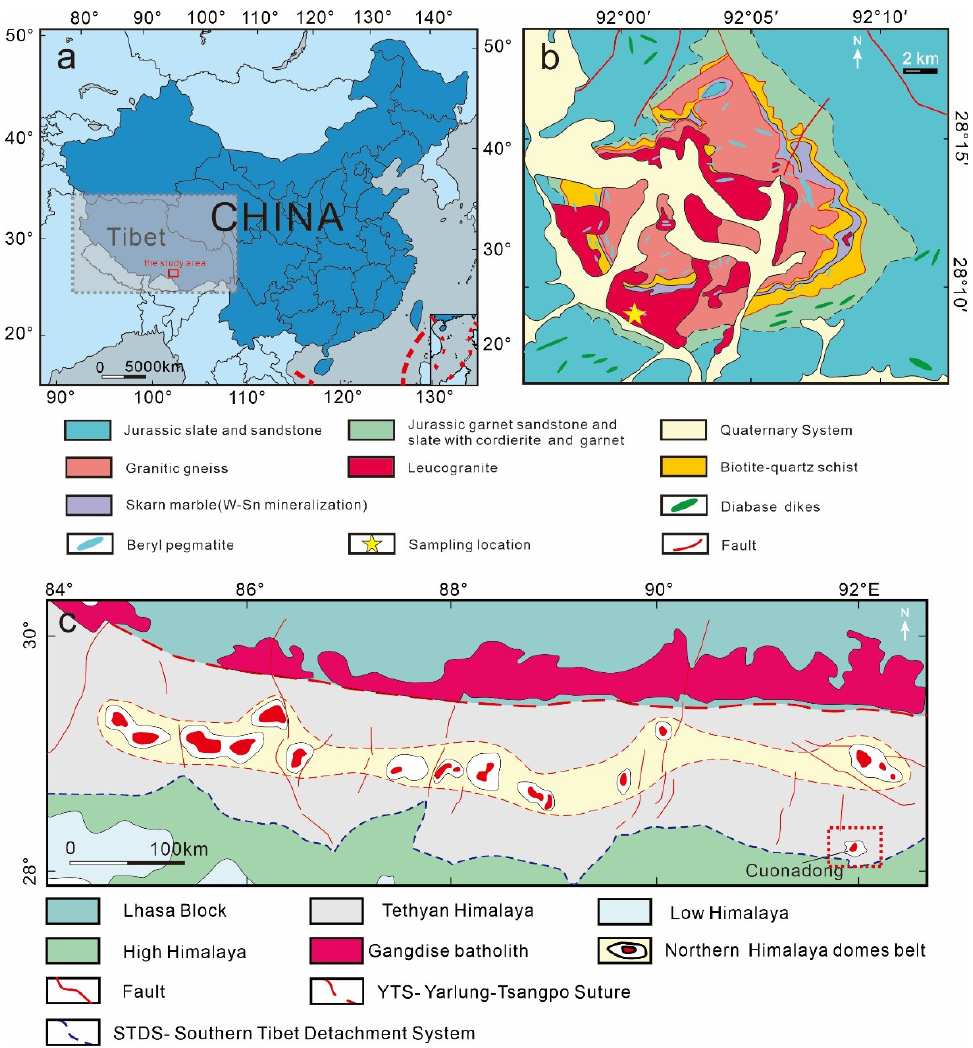
Figure 2. ( a ) Map of China; the yellow part is Tibet and the positions of b and c are located in the red box. ( b ) The structure of the Cuonadong dome [31]; the sampling place is marked as the yellow star. ( c ) Map of the Tethys Himalayan leucogranite belt. [29] The Cuonadong dome is in the lower right corner of the figure. Figure 2b is in the boxed area of Figure 2c.